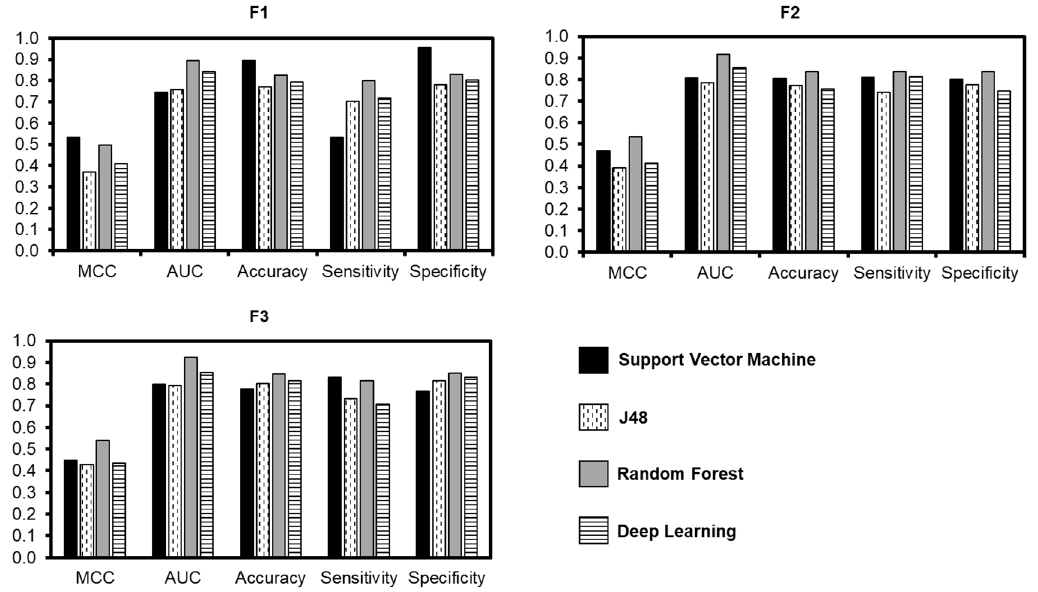
Figure 3. Evaluation of candidate models achieved from applying feature F1, F2, F3 on algorithms: SMO, J48, RF, and DL.